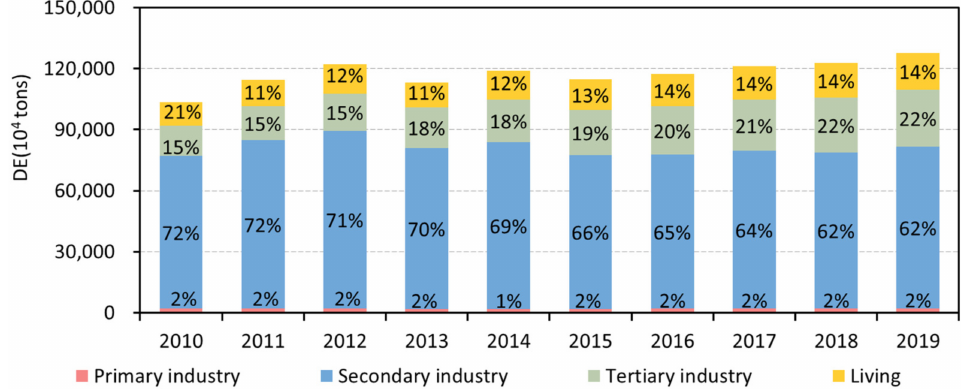
Figure 9. Composition of carbon emissions in southwest